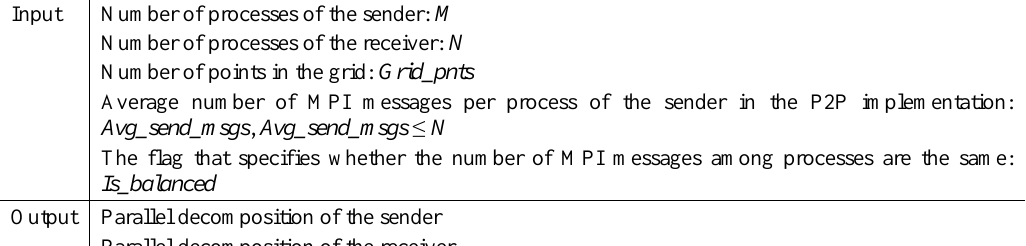
Algorithm 1. Generating the parallel decompositions of the sender and the receiver according to an average number of MPI messages of the sender in the P2P